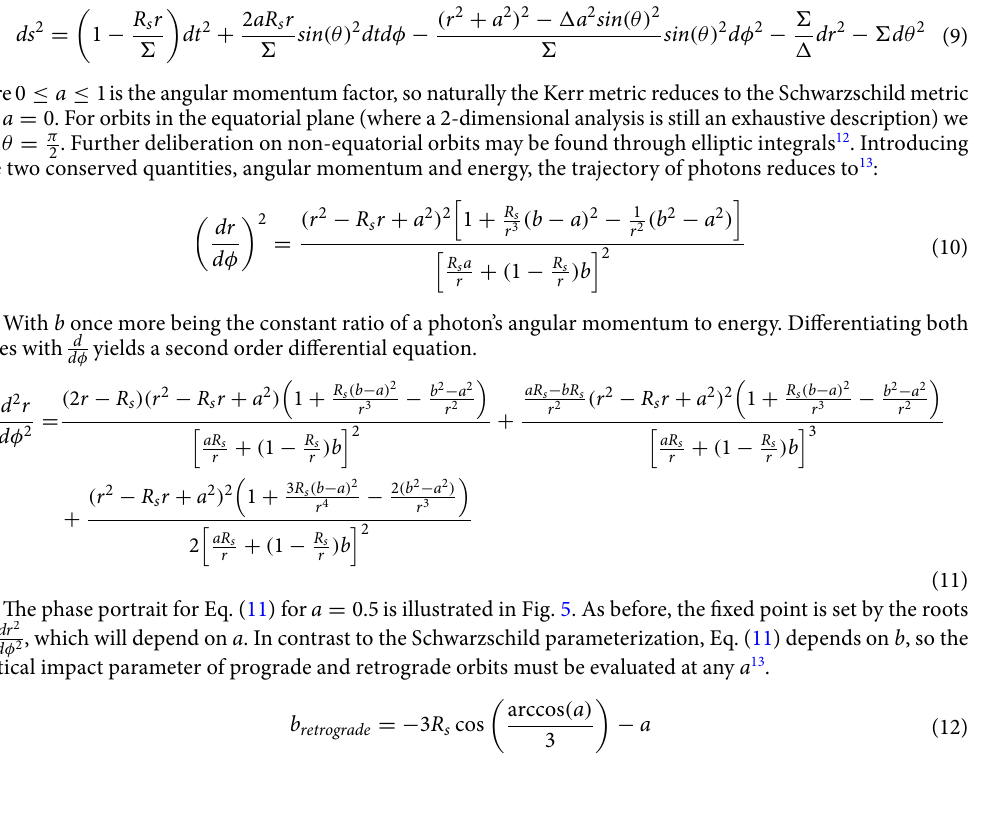
Figure 4. The radial distance between a light-ray (with δ 0 of deflection angle [in blue]. The predicted analytical combination of an exponentially declining ( e − φ ) and exponentially growing ( e φ ) term is indicated with a yellow dashed line. Evidently, each term dominates at different angles of φ , with fitted lines suggesting δ 1 solution no longer